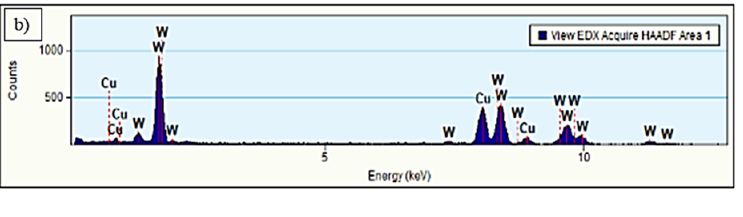
WC [111] ( a ); with letter B: W 2 C [011] ( b ); with letter C as the matrix ( c ).